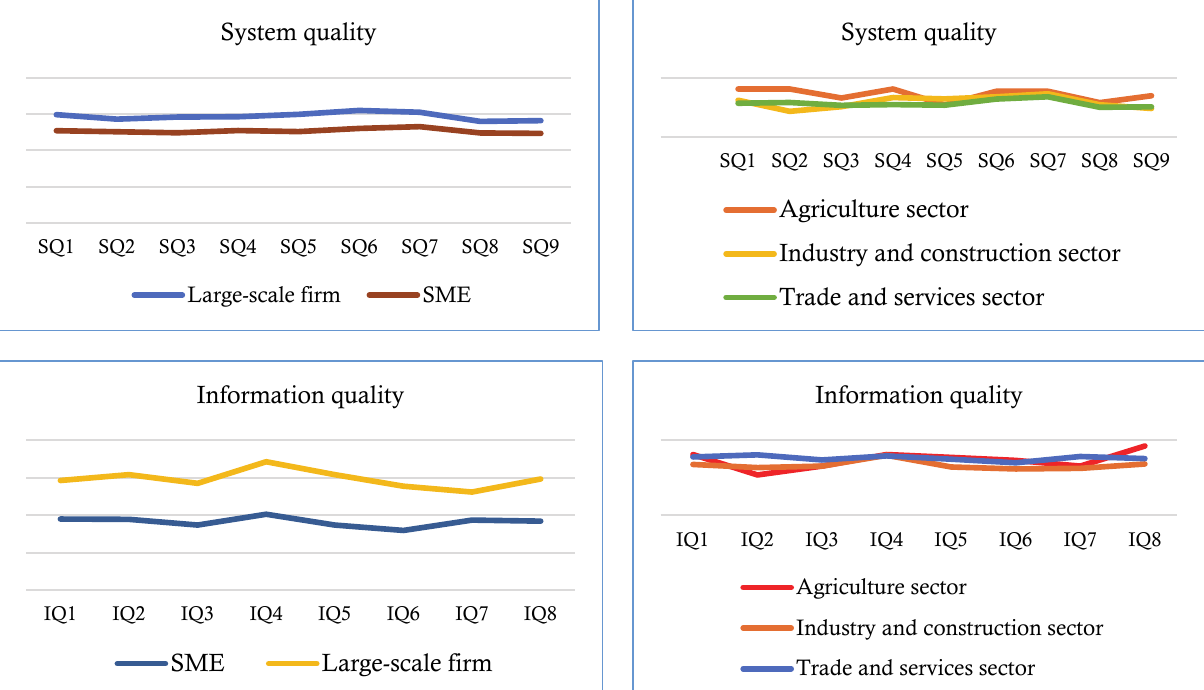
Fig. 2. The comparison of the quality of accounting information system by firm size and business